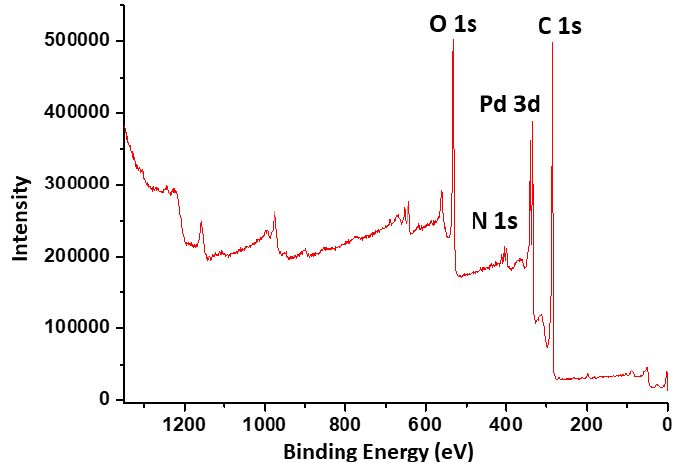
Figure 7. X-ray photoelectron spectroscopy (XPS) scan survey of NDG@Pd composites.